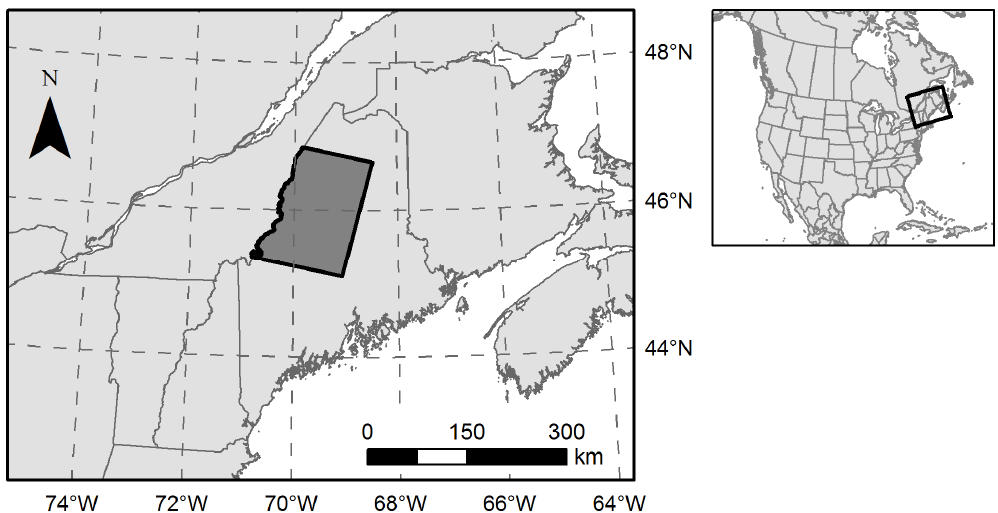
Figure 1. Northern Maine, USA study area encompassing 1.9 Mha of forestland. Political boundaries were obtained from the North American Atlas (Natural Resources Canada, Instituto Nacional de Estadística Geografía e Informática, and U.S. Geological Survey).